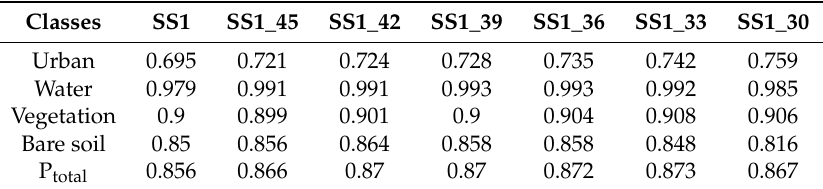
Table 27. Probabilities of correct classification depending on compressed image quality for Set 1, SPIHT coder, ML classifier.